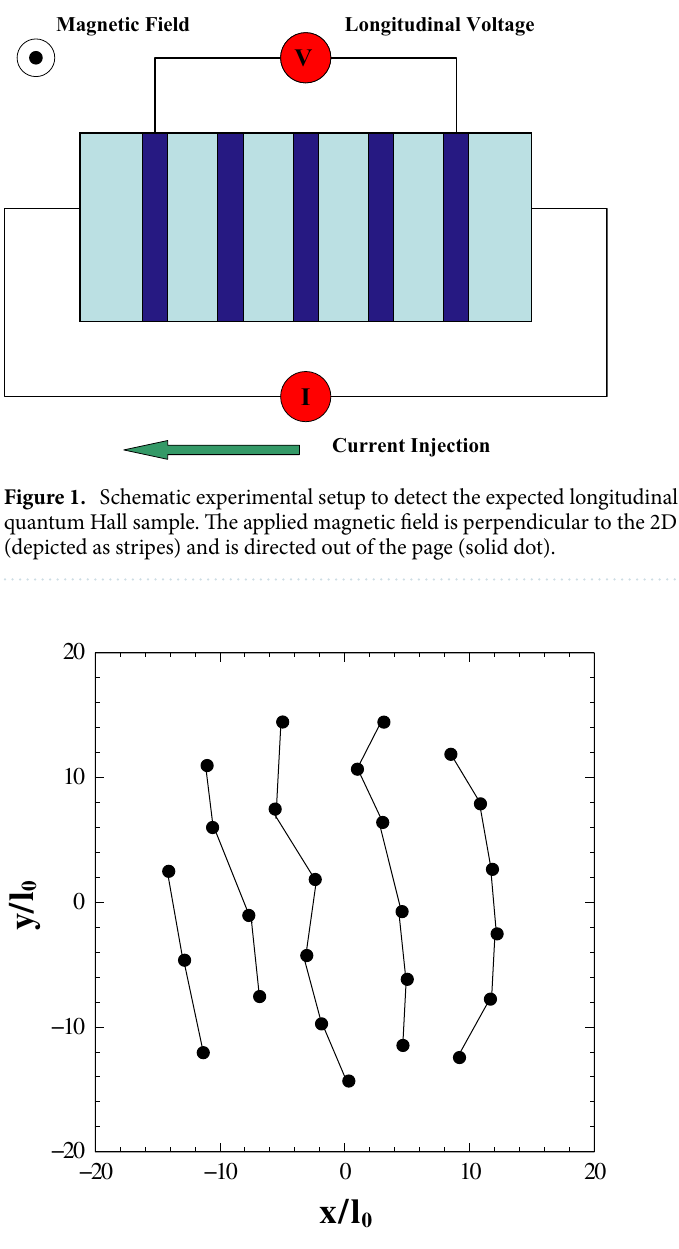
25 electrons obtained from QMC simulations Figure 2. Snapshot of the final configuration of a system of N = 1 / 6 of the LLL and is described by an in a disk geometry. The system corresponds to filling factor ν = 6 (in units of the magnetic length, l 0 ). The system manifests signs of anisotropic BRS wave function with α = layering as shown by the drawn solid lines (that serve as a guide to the